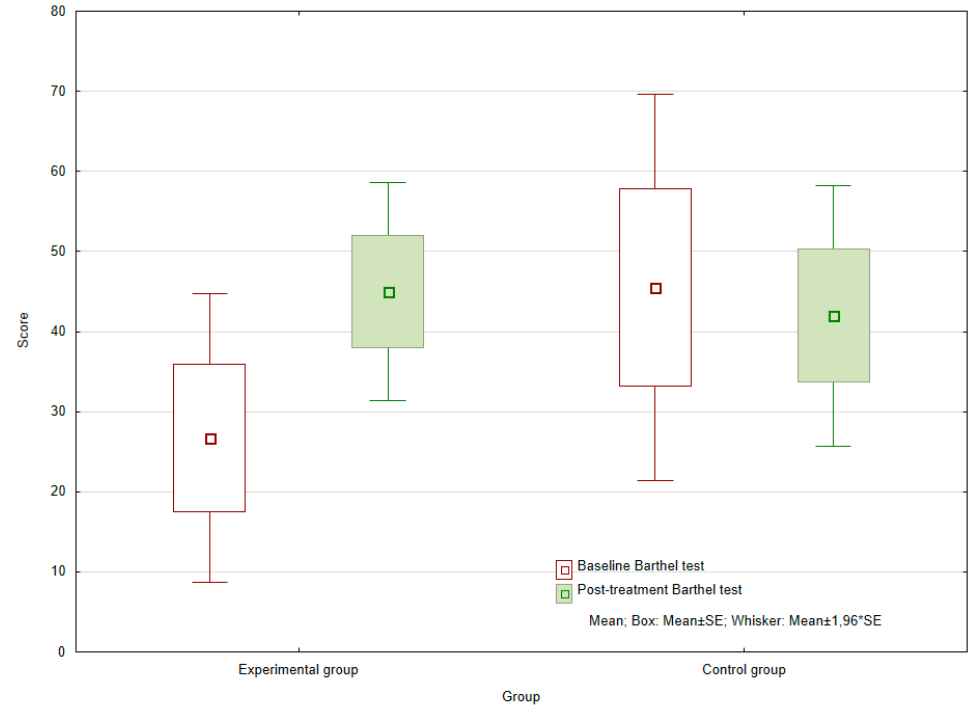
Figure 3. Baseline and post-treatment Barthel index scores of the experimental and control groups.